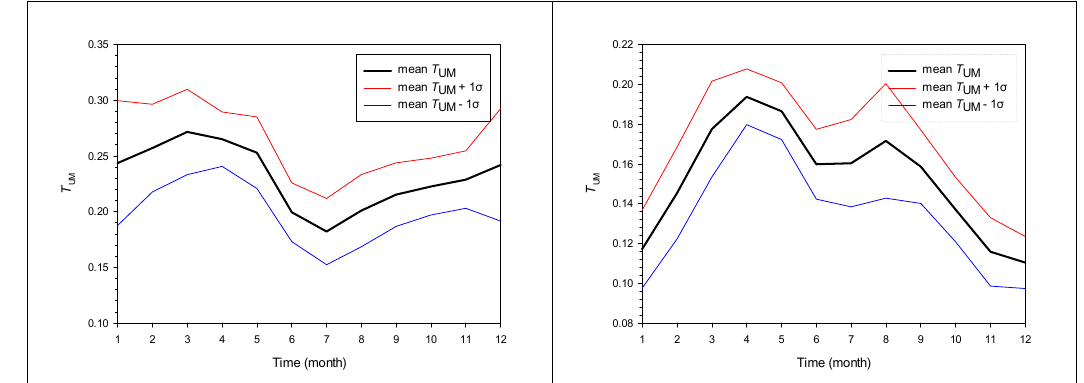
Figure 11. Intra-annual variation of the monthly mean T UM values for all 33 stations during TATY. Upper graph: T UM variation for all-sky conditions. Middle graph: T UM variation for clear-sky conditions. Lower left graph: average T UM variation for all-sky conditions (black line). Lower right graph: average T UM variation for clear-sky conditions (black line). The red and blue lines represent the ±1 σ around the mean.